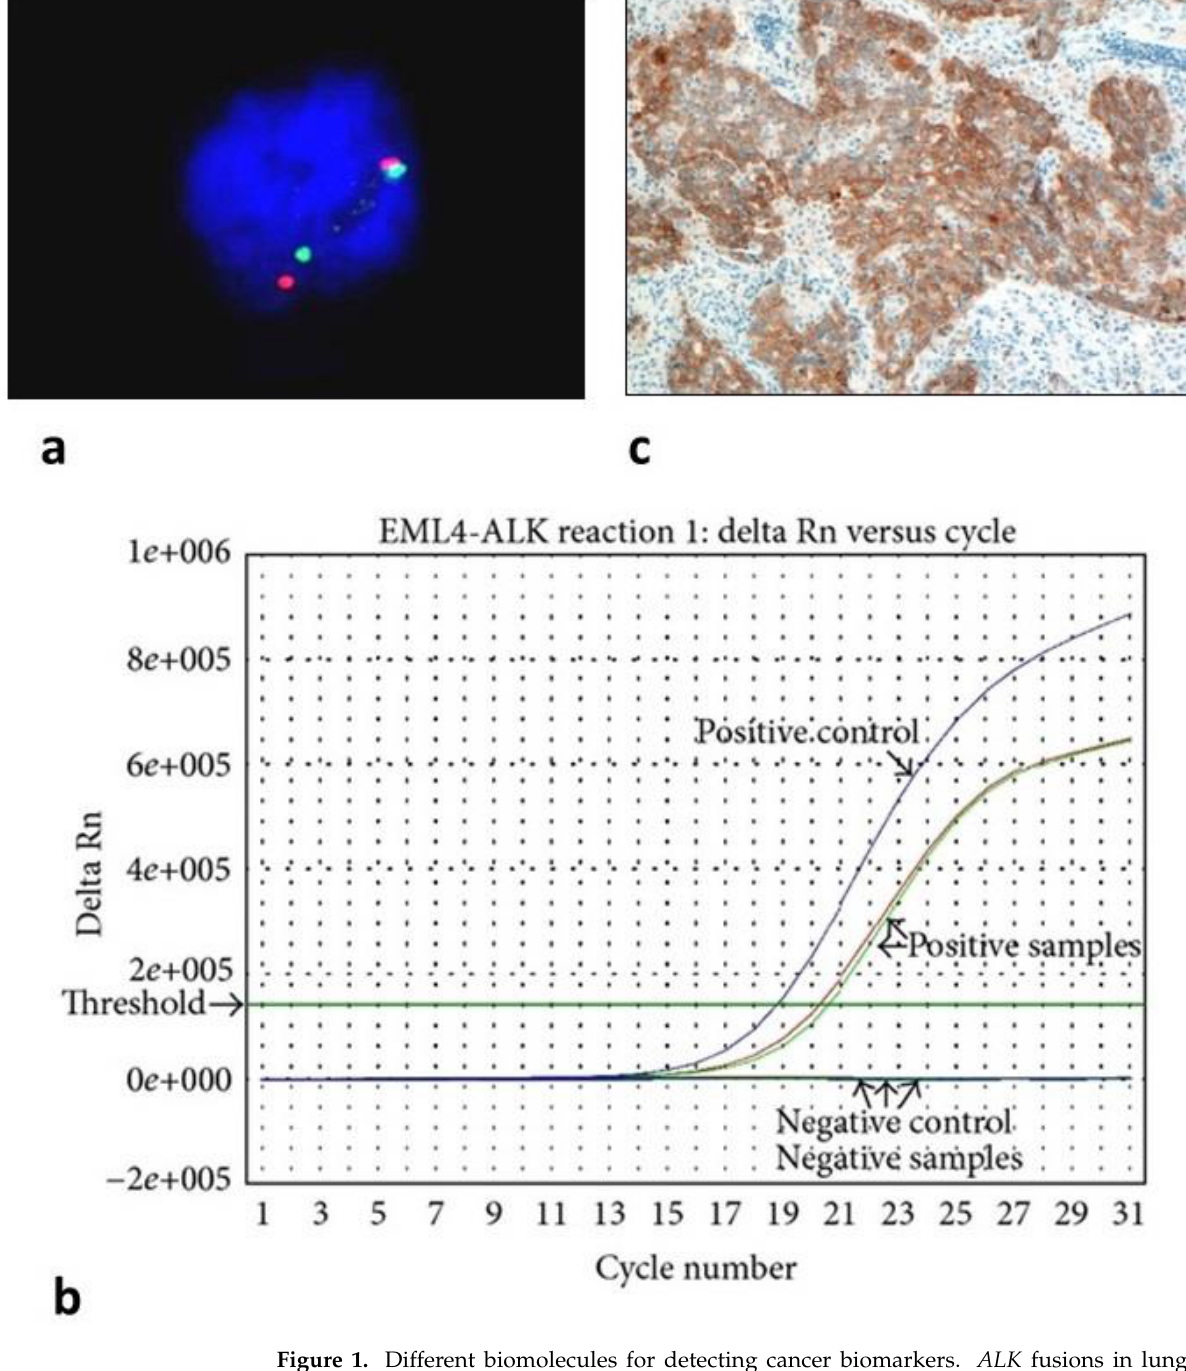
Figure 1. Different biomolecules for detecting cancer biomarkers. ALK fusions in lung tumor tissue detected as ( a ) DNA by fluorescence in situ hybridization, ( b ) RNA by reverse-transcription polymerase chain reaction, and ( c ) protein by immunohistochemistry. Figure modified from Tuonen et al. [15], (open access) under Creative Commons Attribution License.